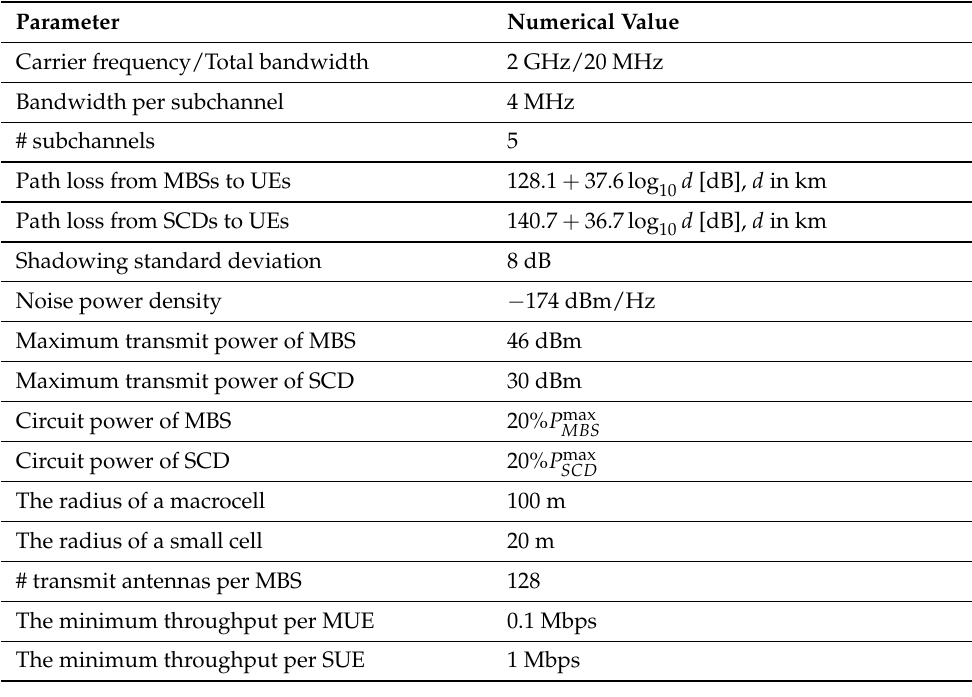
Table 3. Simulation parameters.